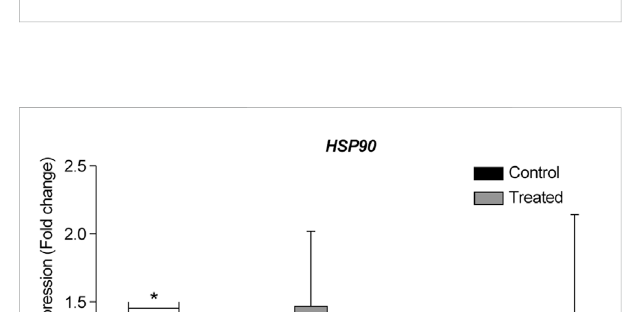
FIGURE 9 ΔΔ Ct oftherelativenormalizedexpressionfor HSP70 inthecontrol (indoor) group and heat-treated (outdoor) chickens at 14-, 21-, 28-, and 35-days of age in the summer of 2021 ( n = 3 in each group, * p < 0.05). HSP, heat shock protein.